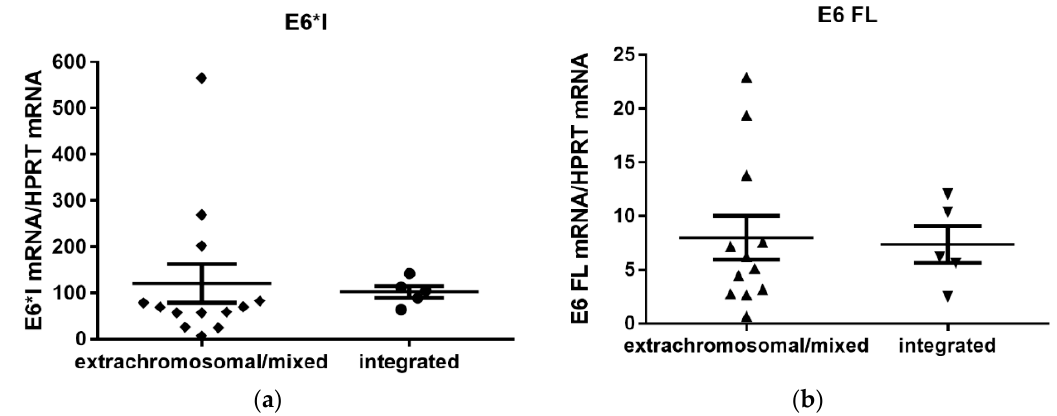
Figure 4. E6/7 oncogene transcription levels. Number of spliced E6 transcripts (E6*I, a ) and full length E6 transcripts (E6 FL, b ) in samples with extrachromosomal/mixed and integrated HPV16 genomes normalized to HPRT mRNA. The difference is not statistically significant ( p = 0.208 for E6*I and p = 0.959 for E6 FL).